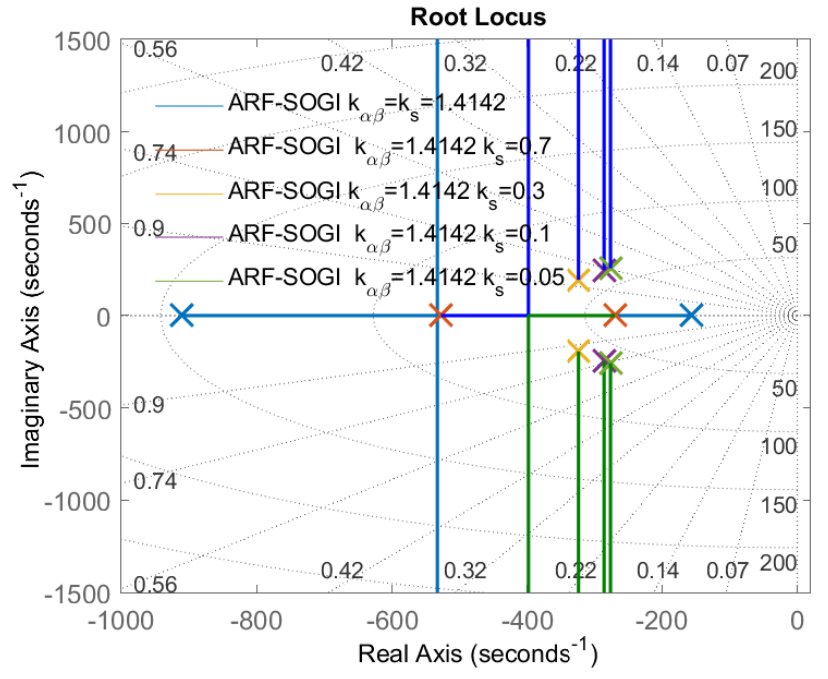
Figure 9. qv (cid:48) ARF-SOGI-QSG poles.